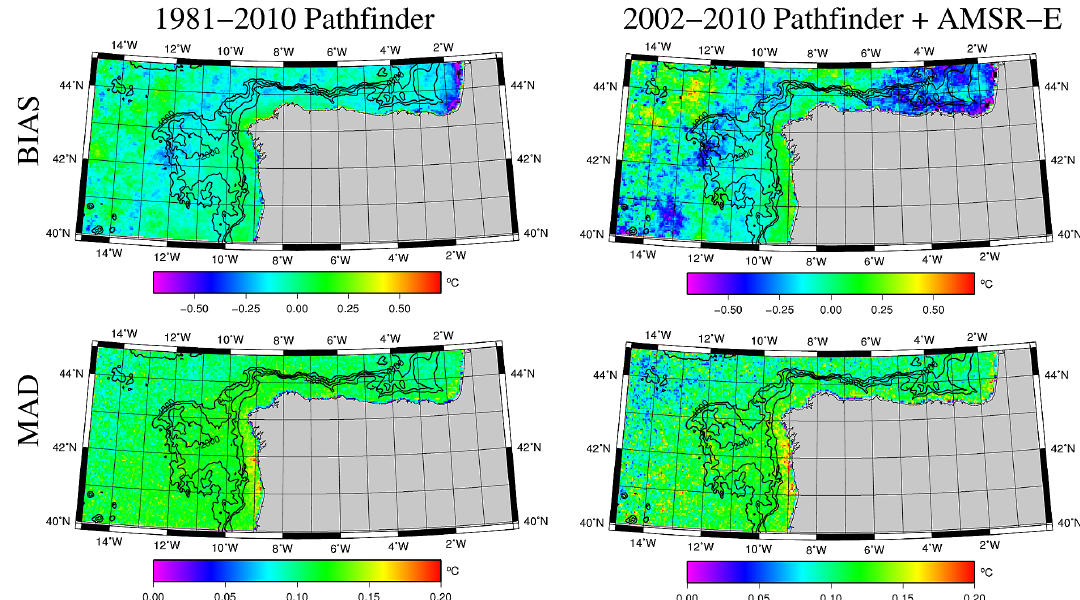
Fig. 2. BIAS ( ◦ C, top panels) and MAD ( ◦ C, bottom panels) error distribution maps obtained comparing originally non-missing satellite data with their reconstructed counterparts. The left panels show error maps for the 1981–2010 Pathfinder alone reconstruction and the right ones those of the combined Pathfinder AMSR-E